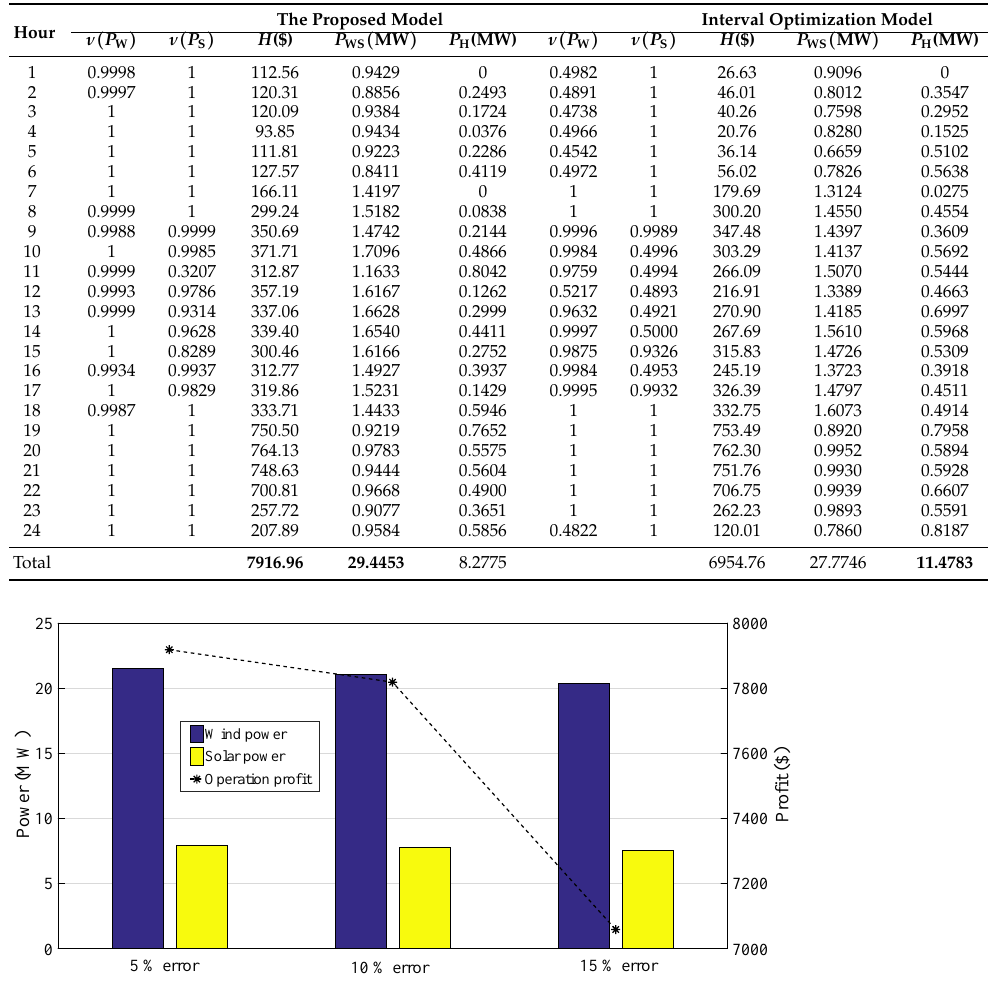
Figure 6. Optimal profit, wind, and solar power under different forecasting